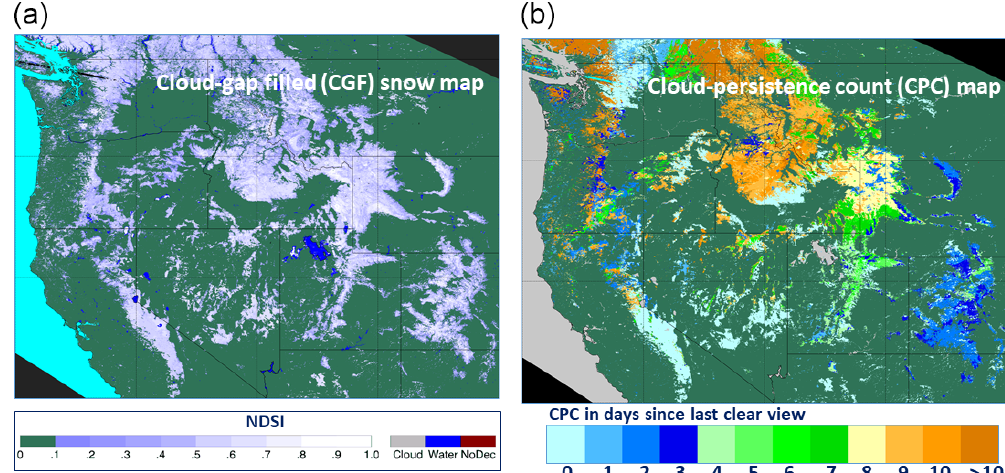
Figure 4. (a) Terra MODIS cloud-gap-filled (CGF) MOD10A1F snow map for 19 March 2012. (b) Cloud-persistence count (CPC) map from the quality assurance (QA) data set for the CGF snow map in (a) . For 19 March 2012, when a pixel has a CPC of zero, it means that the NDSI value for that pixel was acquired on 19 March 2012. When a pixel has a CPC of one, it means that the NDSI pixel value is 1d old, and was therefore acquired on 18 March, and so on. The base map was obtained from Interactive Data Language (IDL) software that uses Natural Earth raster + vector map data, which are in the public